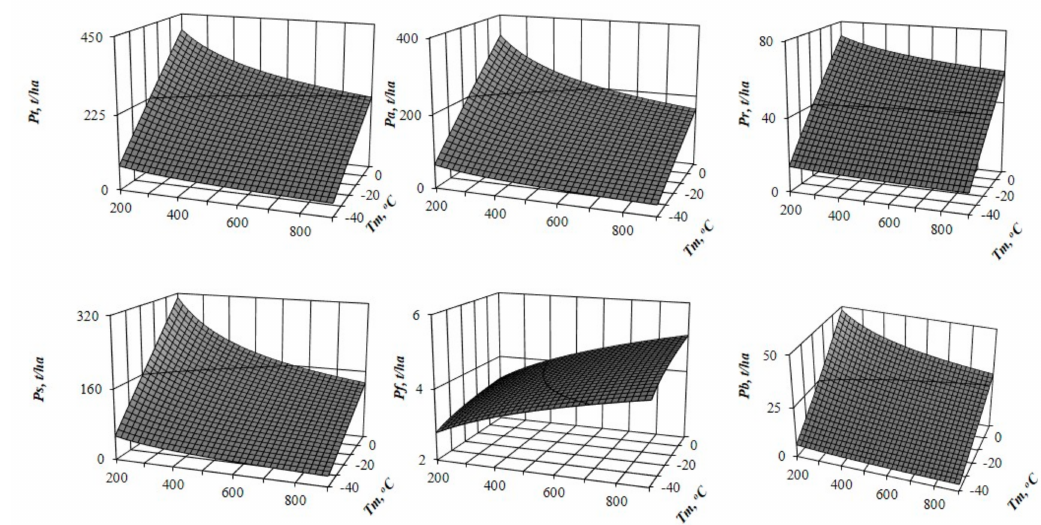
Figure 2. Dependence of Populus ecosystems of Eurasia upon the mean January temperature ( Tm ) and mean annual precipitation ( PRm ). Abbreviations: Pt , Pa , Ps , Pr , Pf , Pb are, respectively, biomass of: total wood storey, aboveground, stems (wood and bark), roots, foliage, and branches, t /